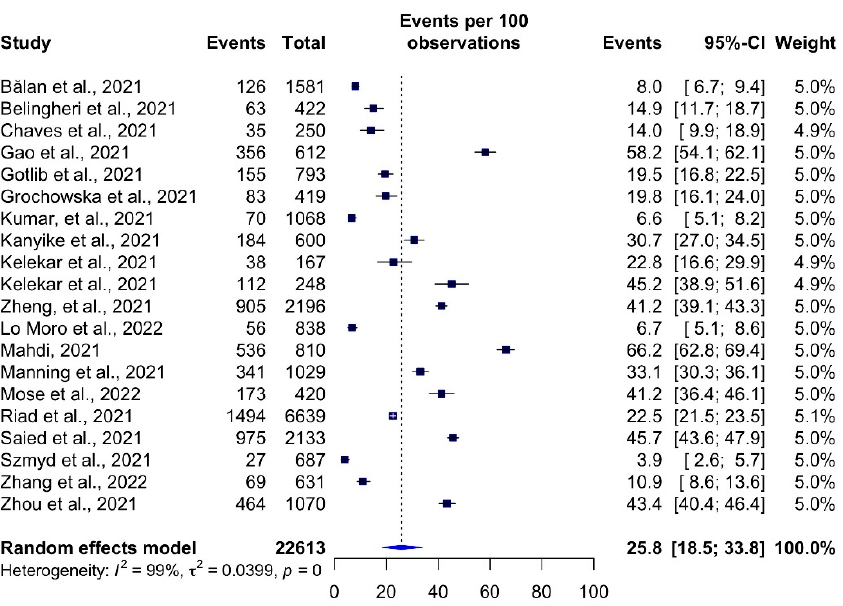
Figure 3. COVID-19 vaccine hesitancy rates among healthcare students by study.